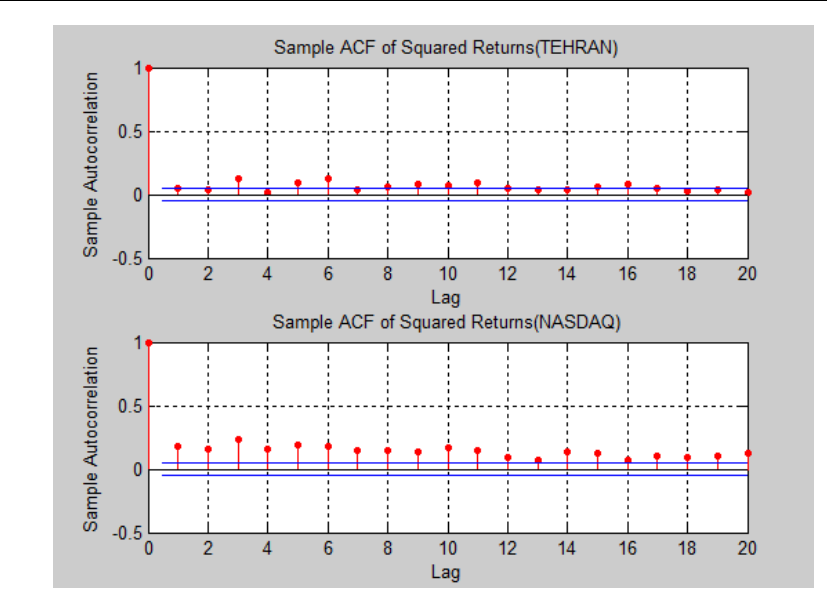
Fig. 3. Sample ACF of the Squared Returns.